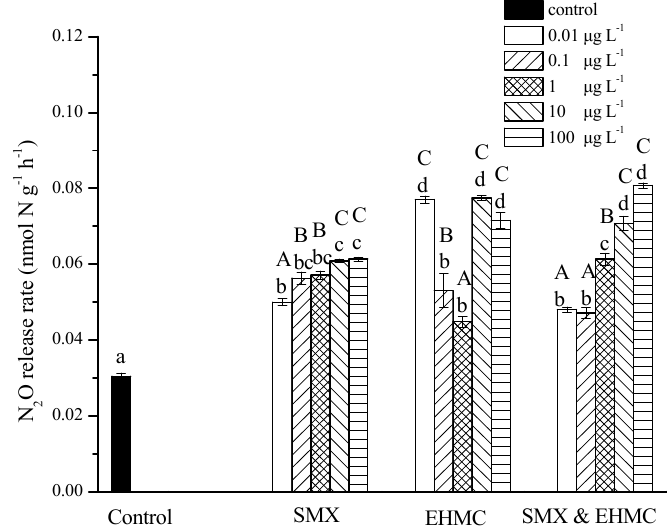
Figure 4. The effects of SMX and EHMC on N 2 O release. The values are the means and the error bars represent the standard deviations (n = 3). The treatment groups sharing different lowercase letters represent significant differences ( p < 0.05). The uppercase letters indicate significant differences between concentrations in the same treatment ( p < 0.05).